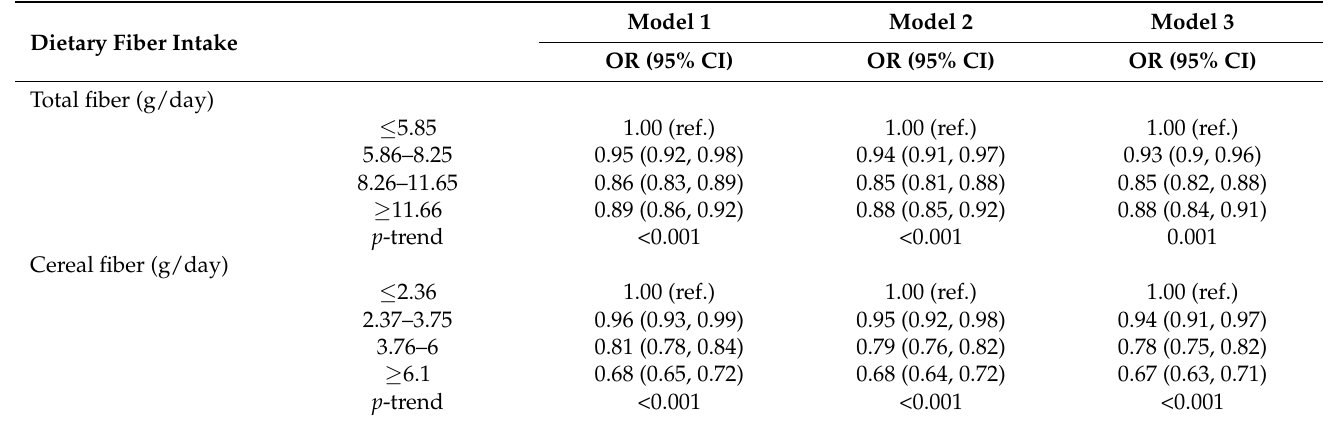
Table 4. Multivariate-adjusted ORs (95% CIs) of hyperuricemia according to dietary fiber intake ( n =